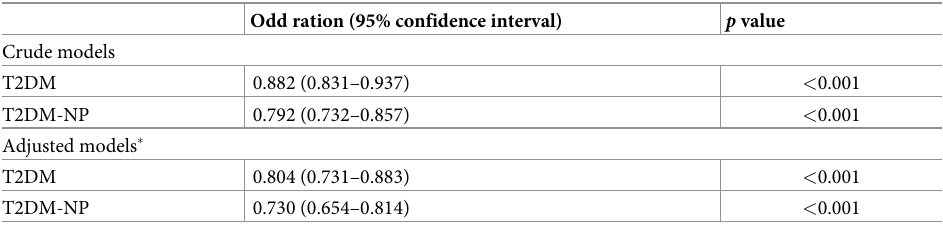
Table 2. Odd ratio for T2DM and T2DM-NP per 10 ng/mL increase in serum levels of CTRP3. Odd ration (95% confidence interval) p value Crude models